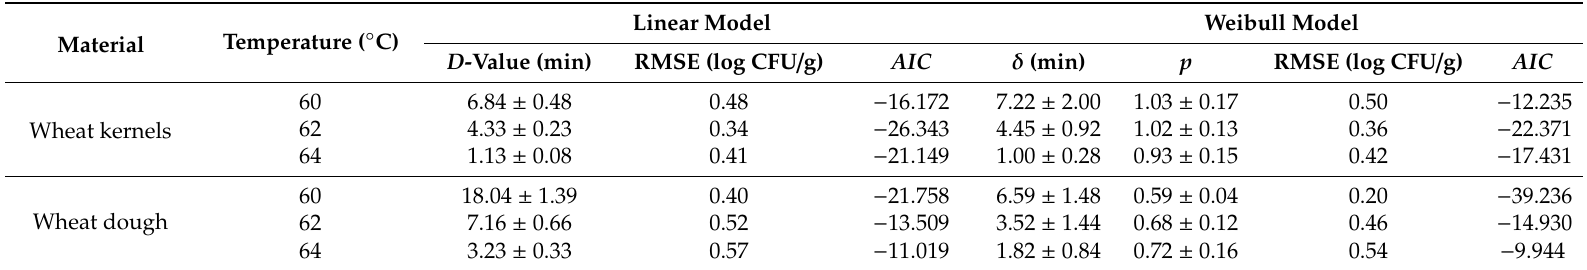
Table 3. Parameter estimates and RMSE for the primary thermal inactivation models of E. faecium inoculated in wheat kernels and dough at a w of 0.99 and heated at three temperatures with a fixed heating rate of 5 ◦ C / min in the HBS